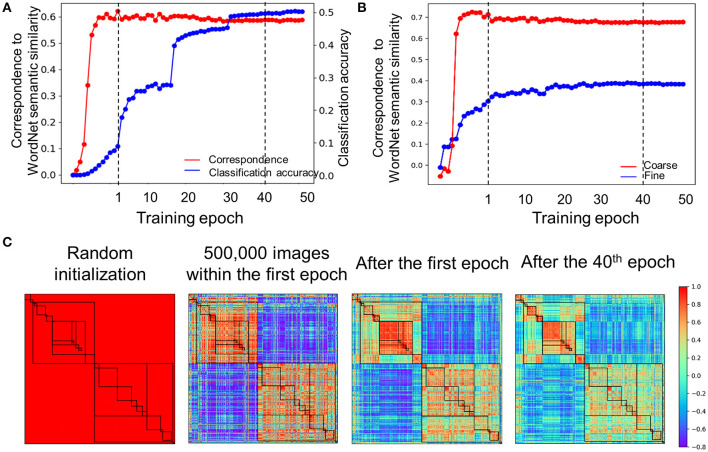
Developmental trajectory of the relatedness. (A) The developmental trajectory of the correspondence in the hierarchical relatedness of object categories between the AlexNet and WordNet (red line). The classification accuracy of the AlexNet was shown in blue. The hierarchical structure evolved into maturity far before the establishment of object recognition ability. To illuminate results within the first epoch, correspondence to the WordNet semantic similarity for every 100,000 images was plotted. Dash line indicates epoch 1 and epoch 40, respectively. (B) A coarse to fine shift during training progression. The coarse structure based on the 19 superordinate categories reached a plateau within the first epoch (red line), while the fine-grained structure reached a plateau after 40 epochs' training (blue line). Dash line indicates epoch 1 and epoch 40, respectively. (C) The category similarities of the AlexNet in different training stages for comparison. From left to right, category similarities of the AlexNet without training, AlexNet trained with 500,000 images within the first epoch, AlexNet trained after the first epoch and AlexNet trained after the 40th epoch. Color bar indicates correlation coefficients.